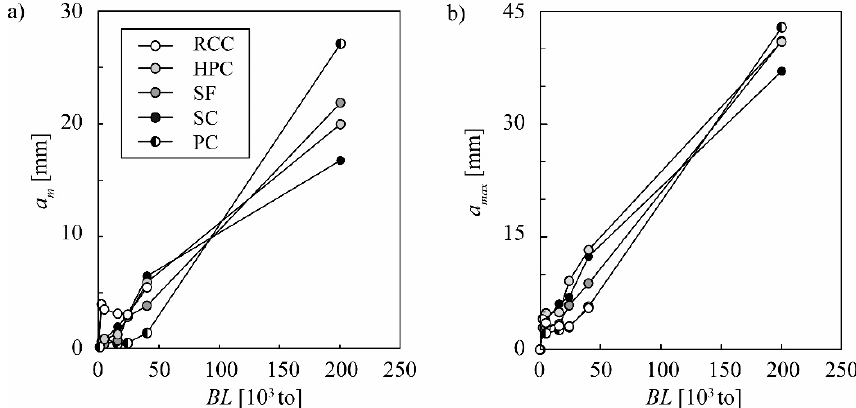
Figure 13. ( a ) Mean and ( b ) maximum cumulative abrasion depths as a function of cumulative bedload mass of invert material test fields in Runcahez SBT.